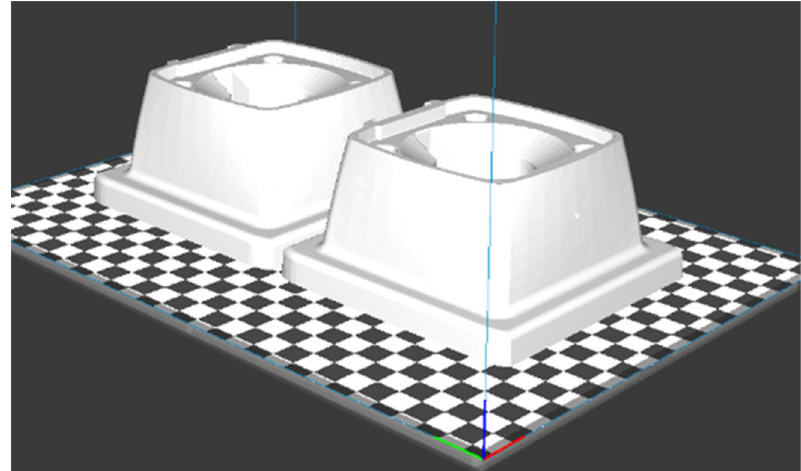
Figure 5. BCN3D CURA software platform simulation the case study part (support) in the original design model.